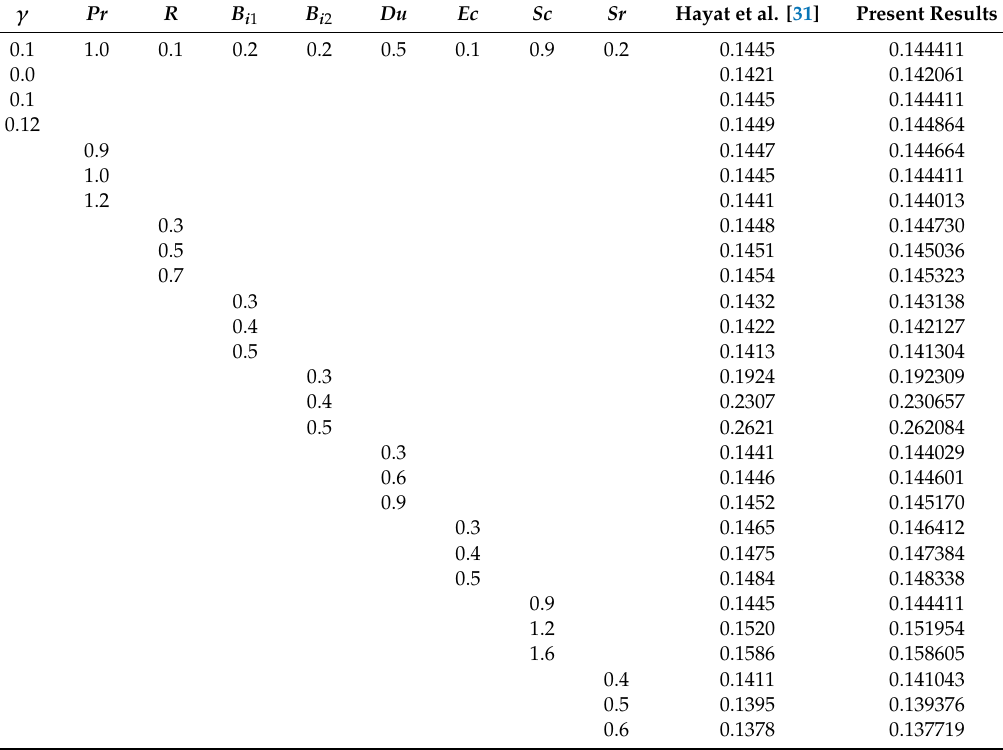
Table 3. Variation in the skin-friction coe ffi cient Cf x / Re 1/2 x for various parameters.